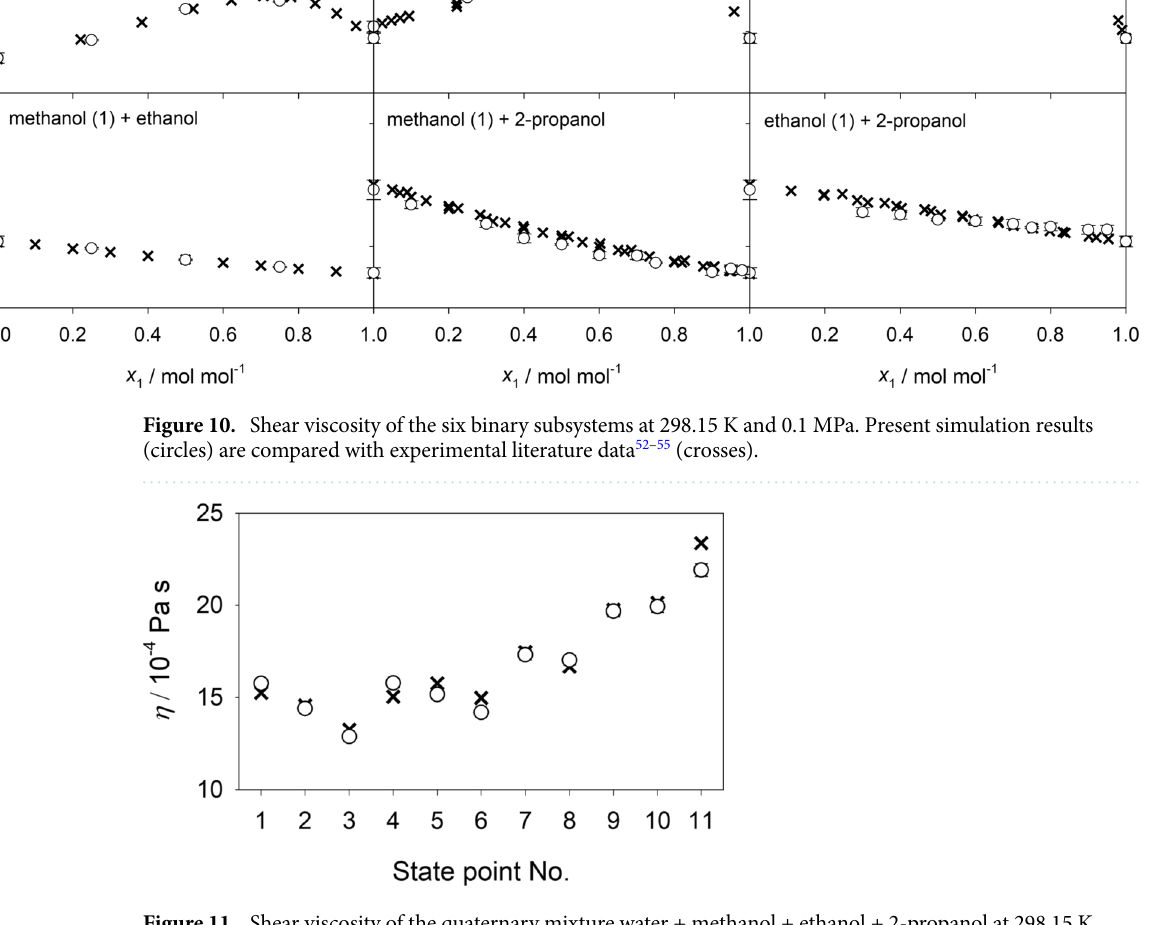
Figure 11. Shear viscosity of the quaternary mixture water + methanol + ethanol + 2-propanol at 298.15 K and 0.1 MPa. The McAllister 51 equation fit to present molecular simulation results (circles) is compared with experimental literature data 56 (crosses). The molar composition of these state points is given in the supplementary Table S7